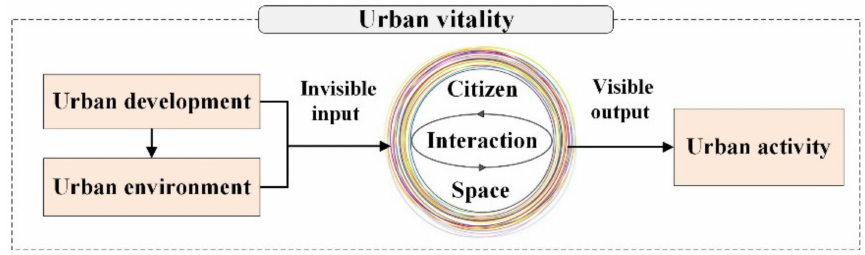
Figure 1. The mechanism of urban vitality